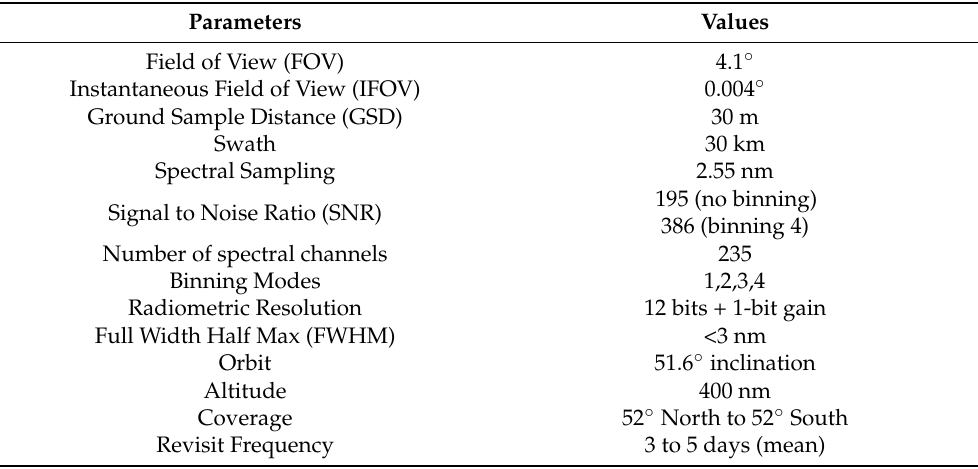
Table 1. DESIS Salient